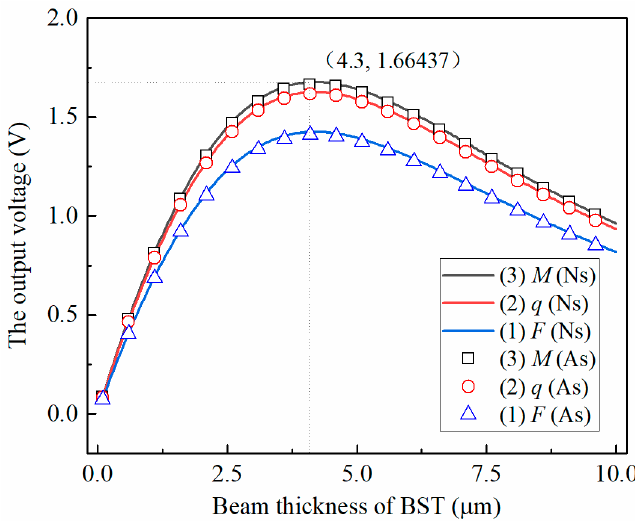
Figure 3. Voltage of the flexoelectric beam under the concentrated load F , distributed load q , and couple load M ( Single layer BST) (Ns = Numerical solution, As = Analytical solution).